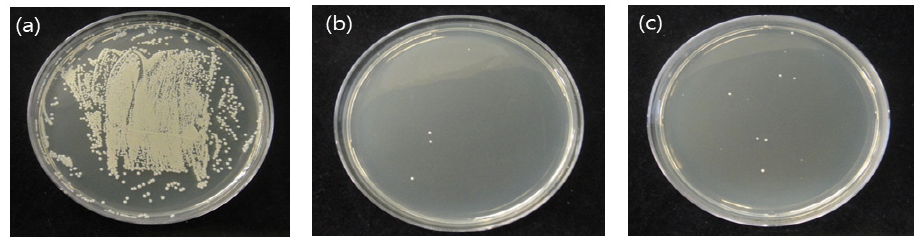
Figure 2. CFU of S. mutans : ( a ) control group, ( b ) nitrogen ‐ plasma ‐ treated group, and ( c ) air ‐ plasma ‐ treated group.